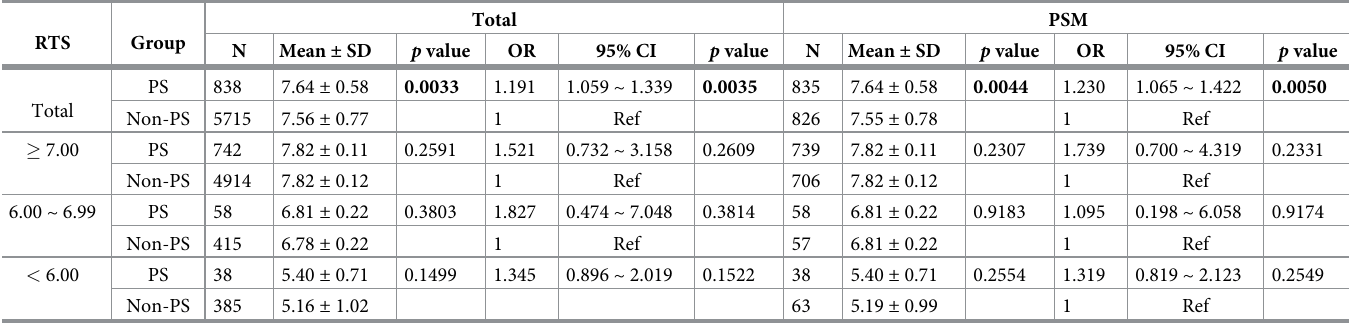
Table 4. Regression analysis of Revised Trauma Score